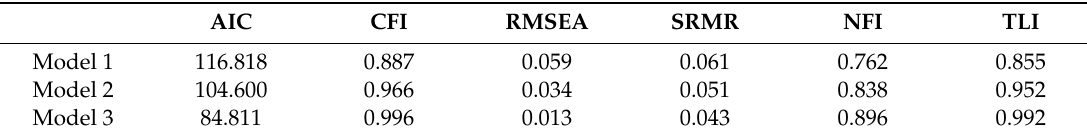
Table 4. Fit indices for the three structure